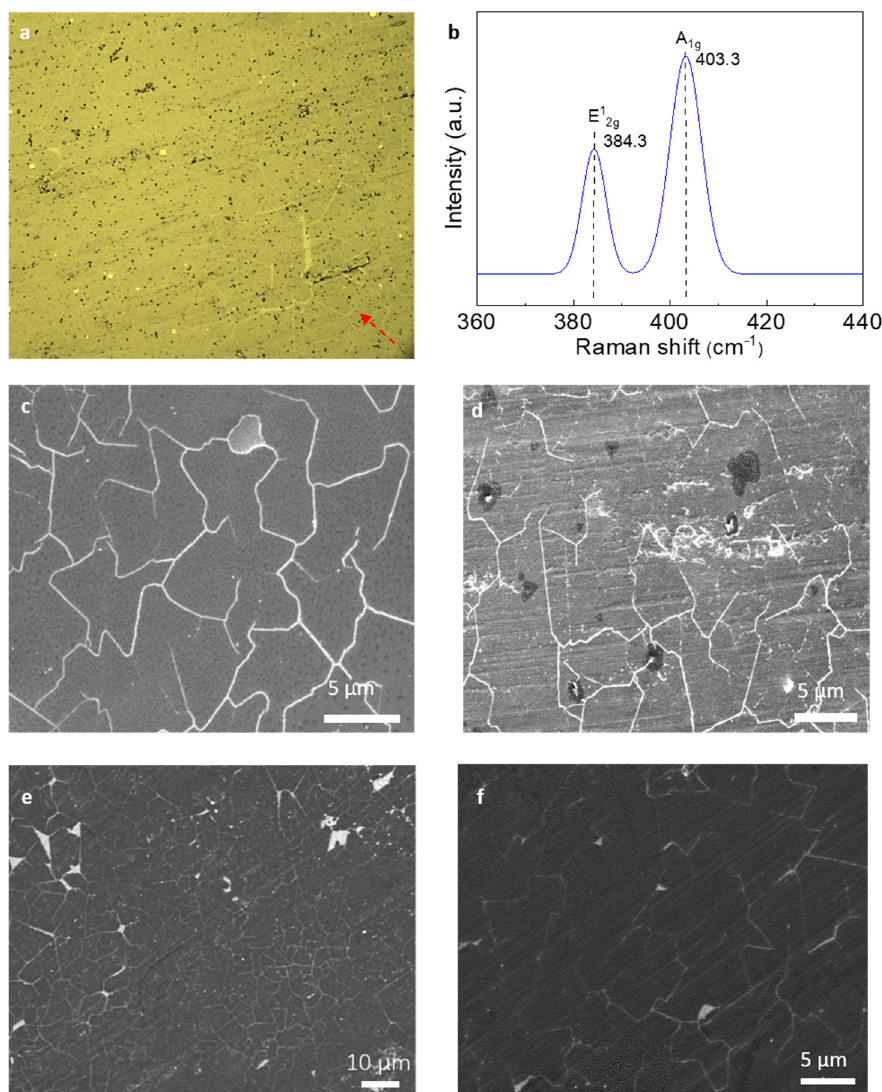
Figure 2. Characterization of the sensor electrodes for flexible sensors. Scanning electron microscopy (SEM) images of monolayer MoS 2 . ( a ) Optical image of the monolayer MoS 2 on Au/PI film. ( b ) Raman data of the monolayer MoS 2 . ( c , d ) SEM of the monolayer MoS 2 before and after transfer process. ( e , f ) SEM image after 5000 cycle stability test.